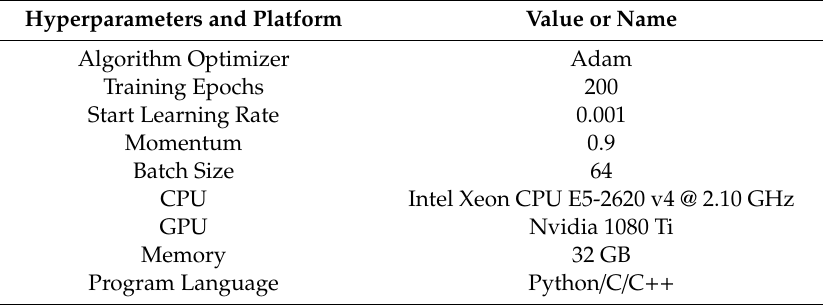
Table 3. Hyperparameters and training